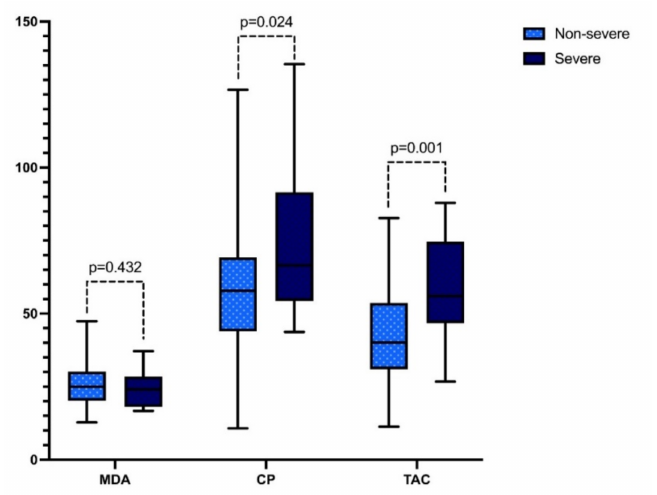
Figure 1. Oxidative stress markers in pregnant women with COVID-19. Malondialdehyde (MDA), carbonylated proteins (CP), and total antioxidant capacity